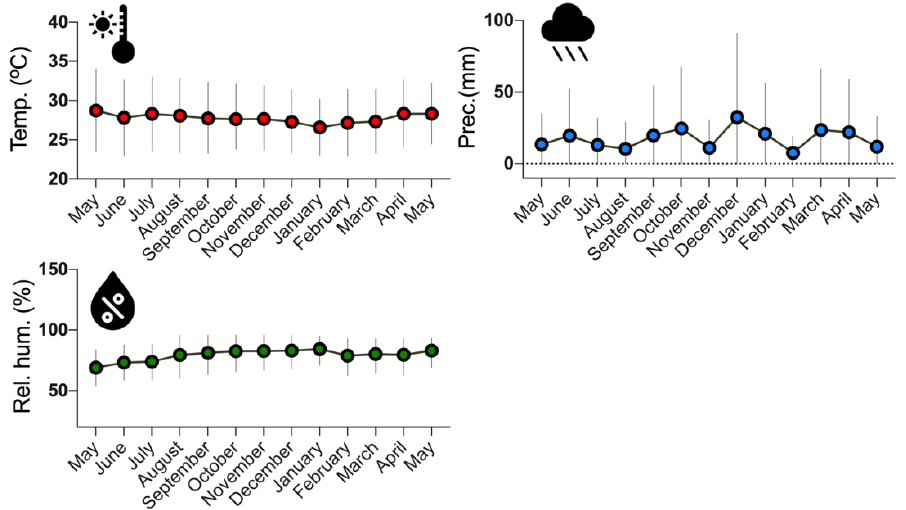
Figure 2. Seasonal monthly variation in seasonal changes in climate: temperature (°C), relative humidity (%), and precipitation (mm) during the sampling months in North Cotabato province, Southern Philippines. The circle ( • ) and error bars represent the monthly mean and min − max values respectively.